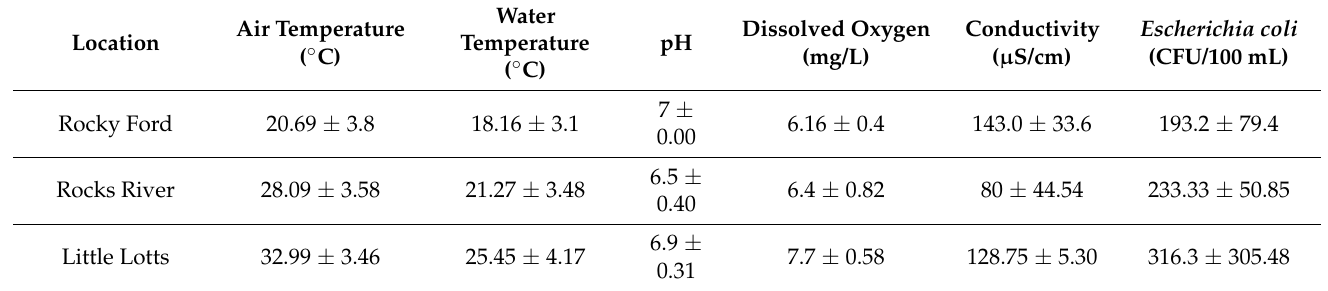
Table 3. Total Water Parameter Averages and Standard Deviations for All Sites. Total Water Parameter Averages and Standard Deviations from January–May